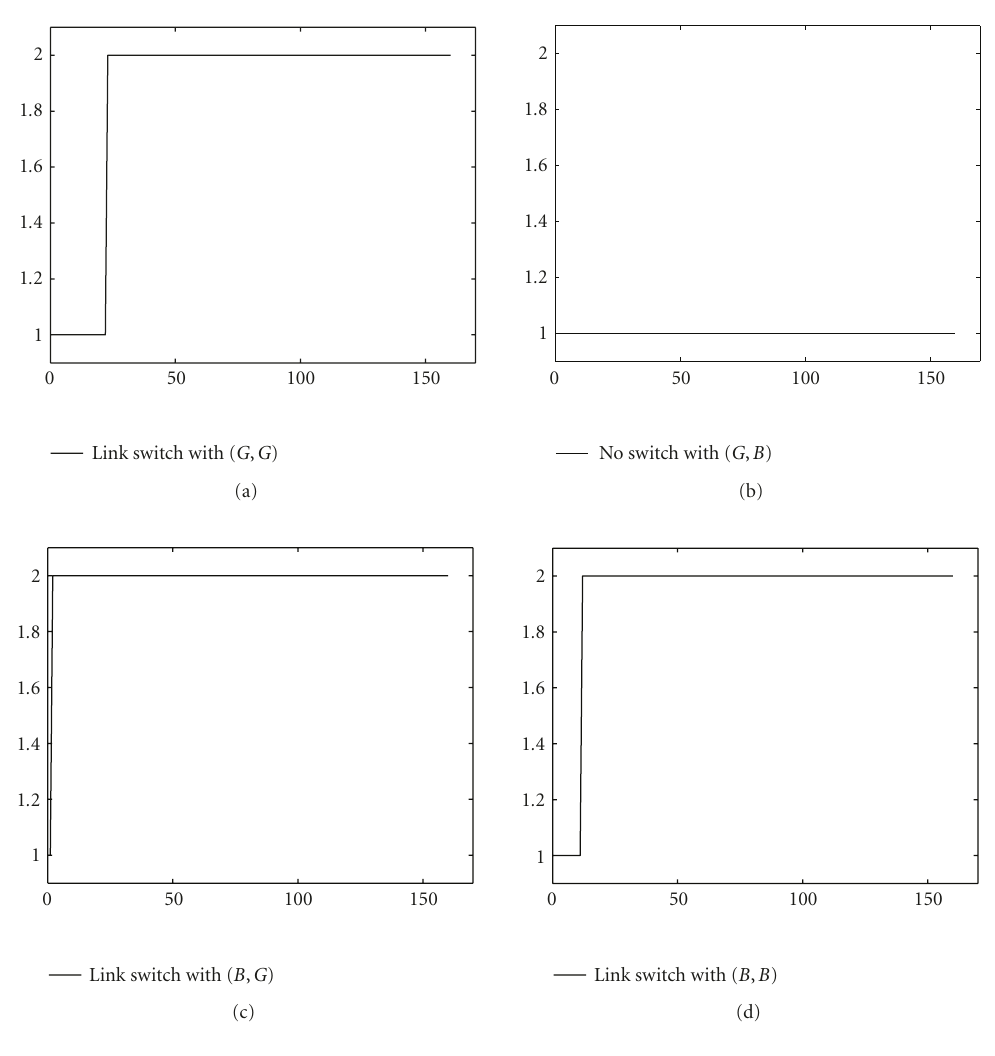
Figure 7: The switch of transmission time between two links due to bu ff er conditions. Horizontal axis: bu ff er level; vertical axis: scheduler